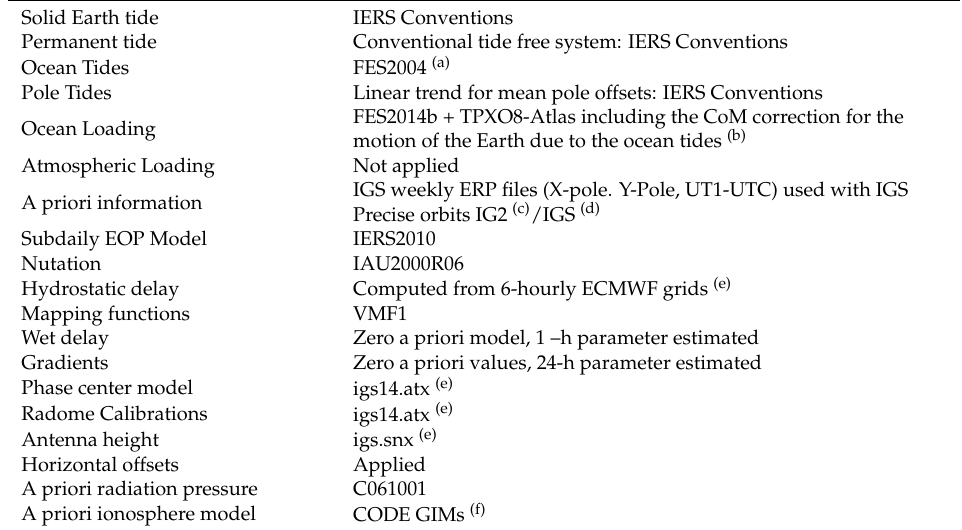
Table 2. Parameters and models used in the GNSS data